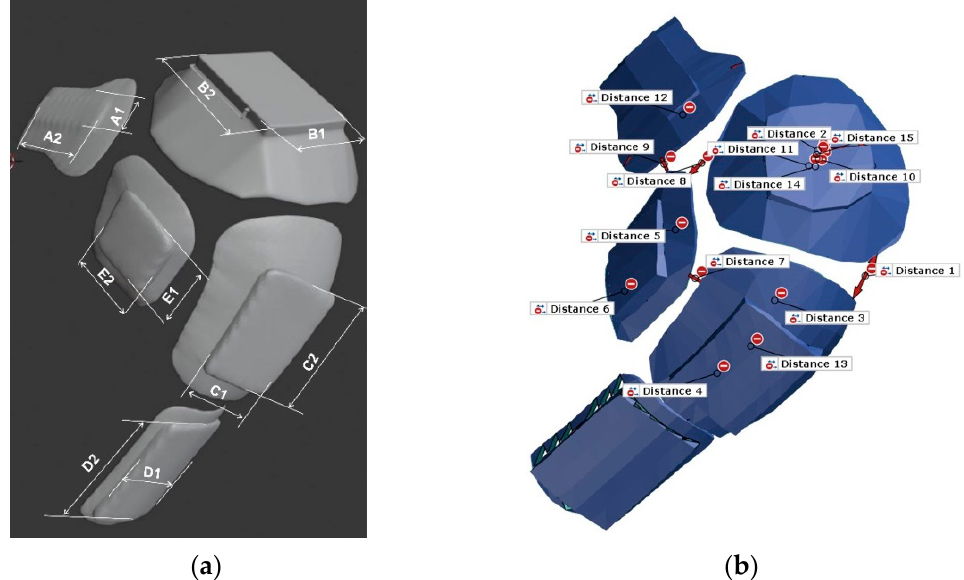
Figure 7. Determining the dimensions of the protector applied to the material ( a ); and the distance between protector elements ( b ).